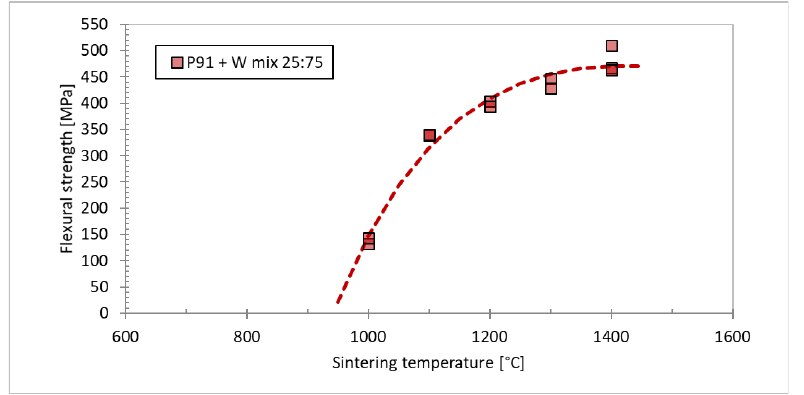
Figure 11. Influence of sintering temperature on the flexural strength of tungsten-steel